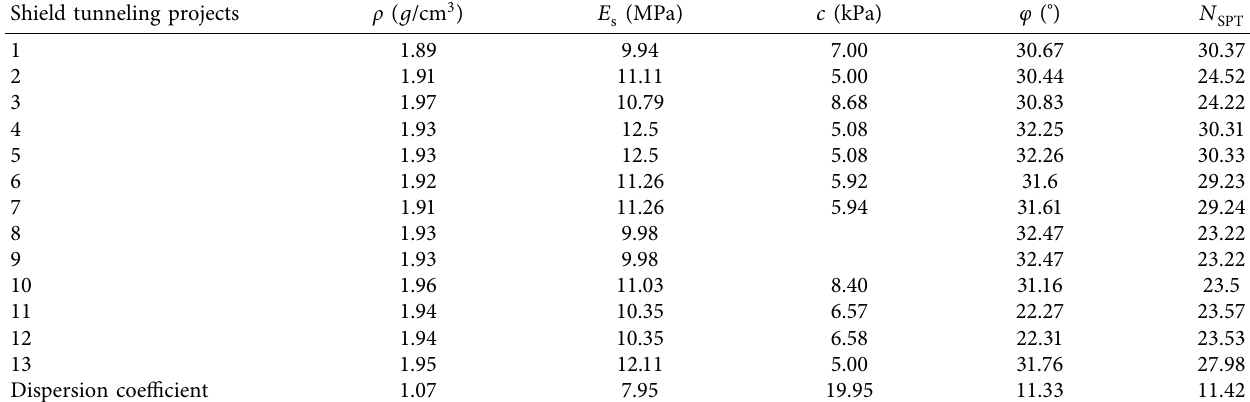
Table 2: Statistical table of main geological parameters of 13 shield tunnel projects. Shield tunneling projects